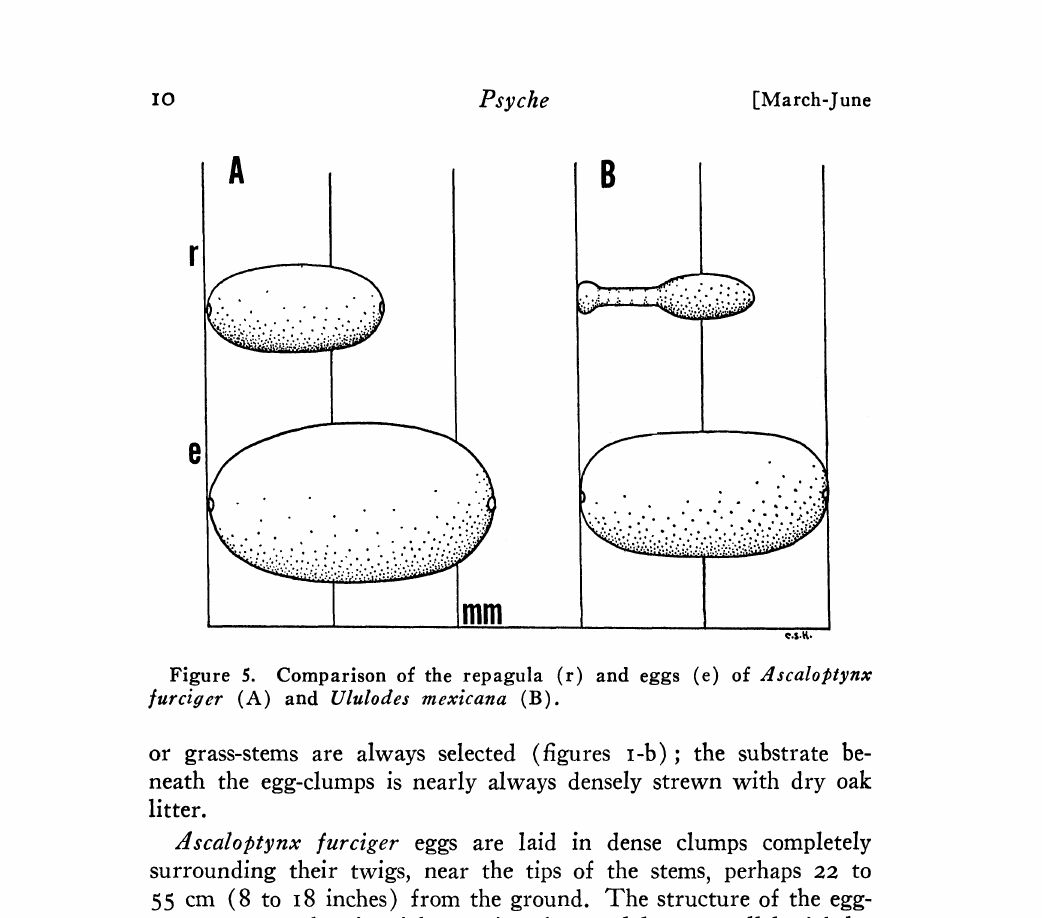
Figure 5. Comparison of the repagula (r) and eggs (e) of Ascaloptynx ]urciger (A) and Ululodes mexicana (B). or grass-stems are always selected (figures -b); the substrate